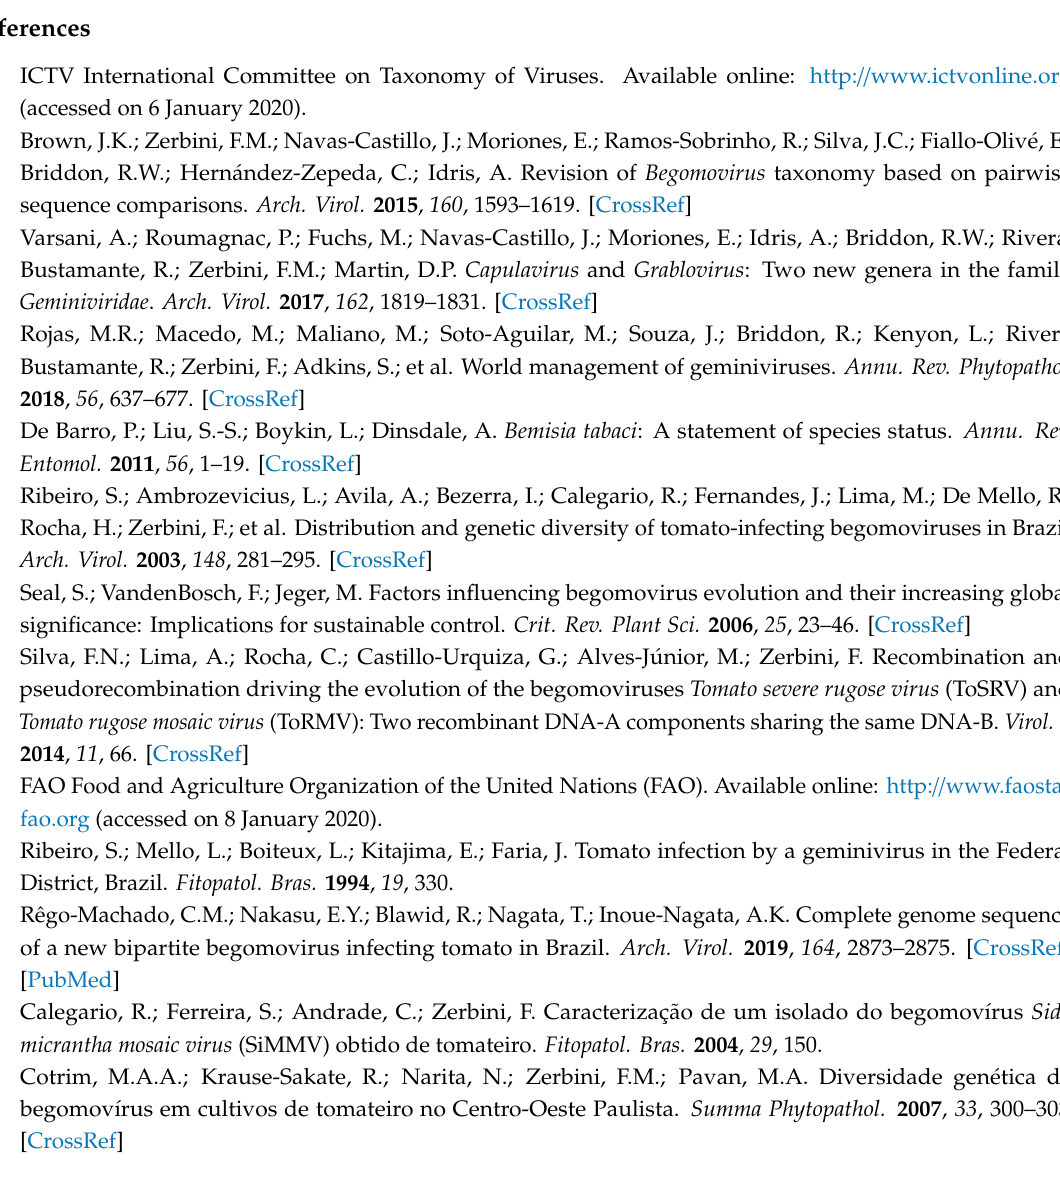
Table S1. Geographic distribution of 21 species of begomovirus reported naturally infecting tomatoes in Brazil. Sample sequences with Ty -1 NGS with